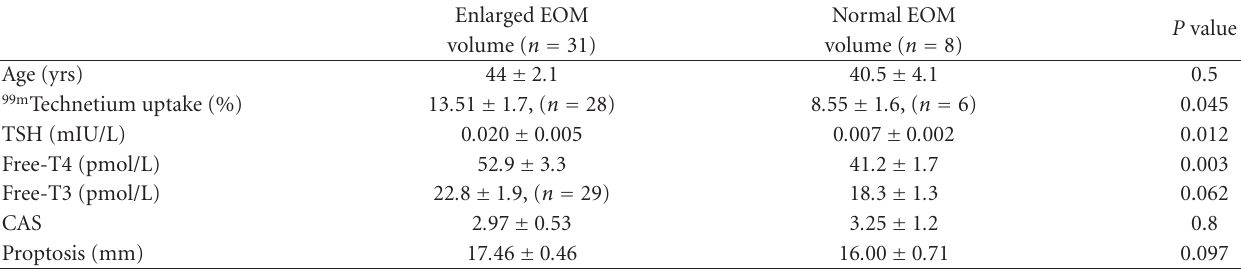
Table 2: Means ± SEM of measurements for patients with and without EOM volume enlargement. Where the measurement was not per- formed on all patients, the number of patients is shown in square brackets. P values calculated using 2-sample t